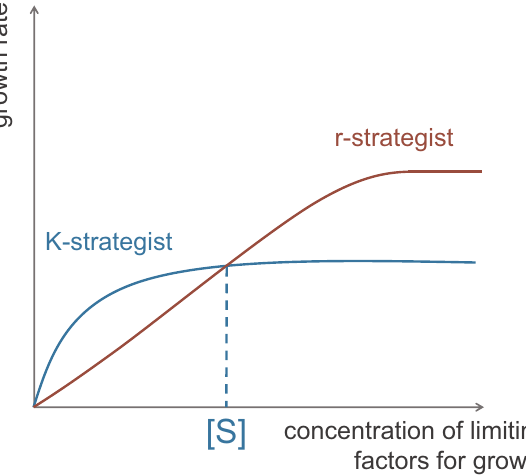
Fig. 1 Growth rate of K- and r-strategists in function of the concentration of growth-limiting factors. At concentrations lower than the critical K/r threshold concentration [S] (blue), K-strategists (naturally present bacteria) will dominate the community, whereas, at higher concentrations, unwanted regrowth of r-strategists (opportunistic pathogens and indicator organisms) can occur. Adapted from De Vrieze et al 46